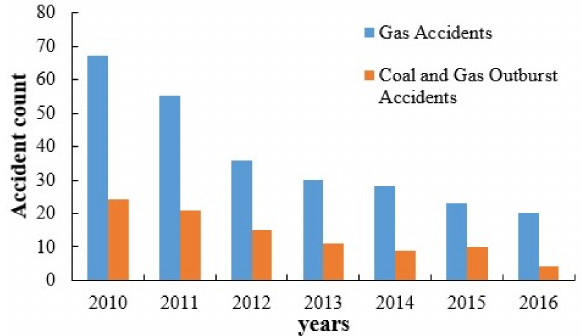
Figure 1. 2010–2016 gas accident statistics of coal mine in